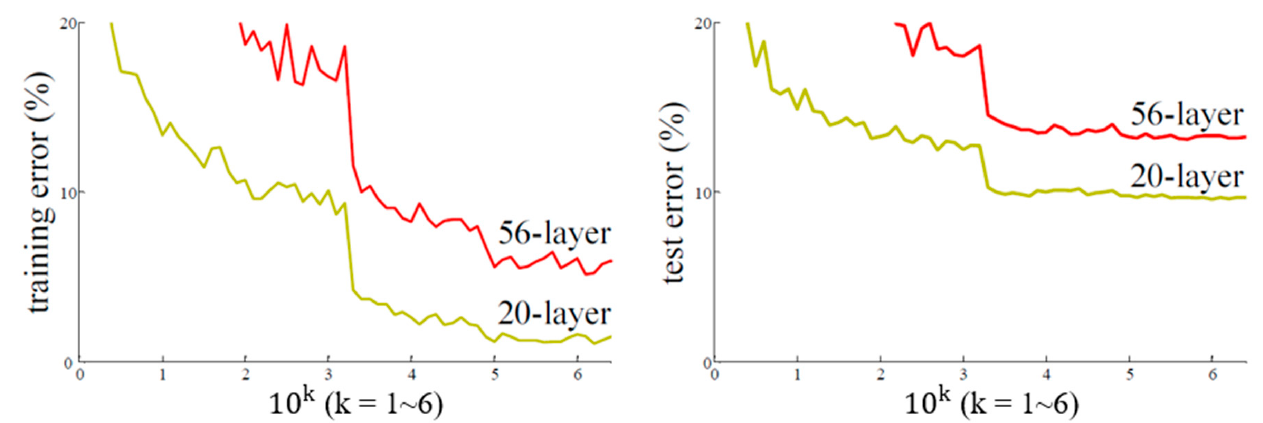
Figure 1. Relationship between number of layers and training error [12].